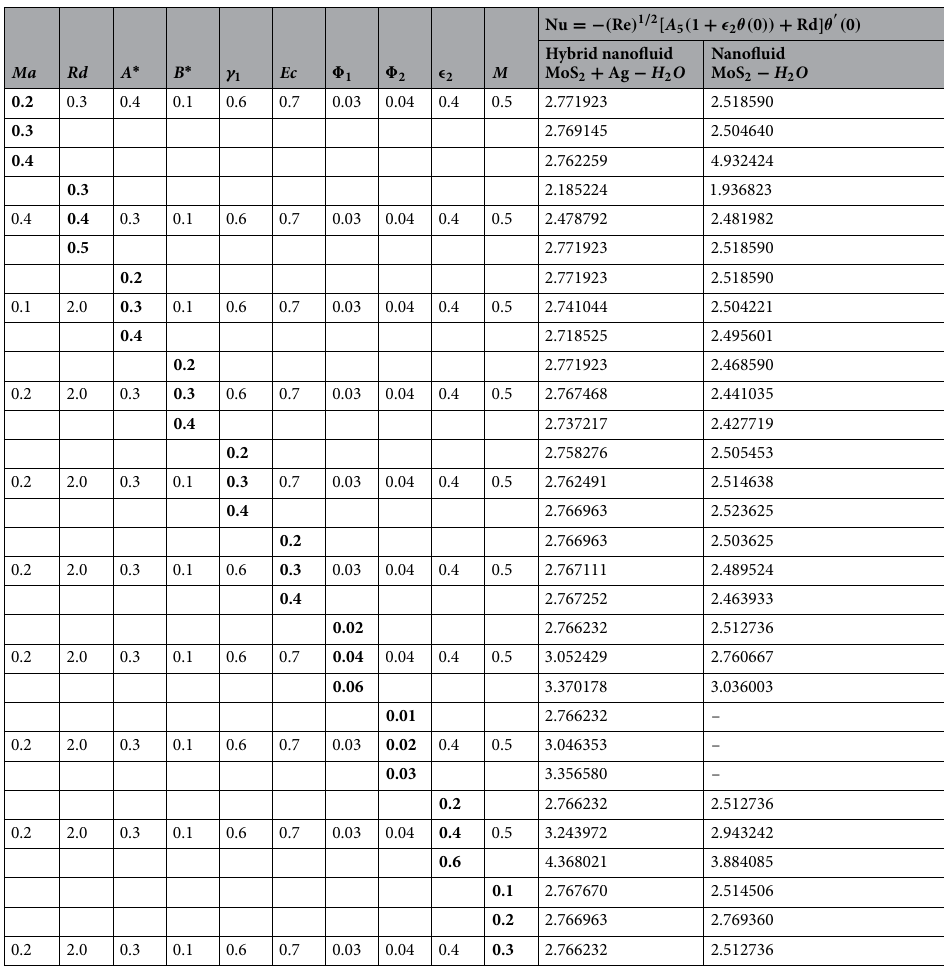
Table 3. Impact of several parameters on Nusselt number. Significant values are in